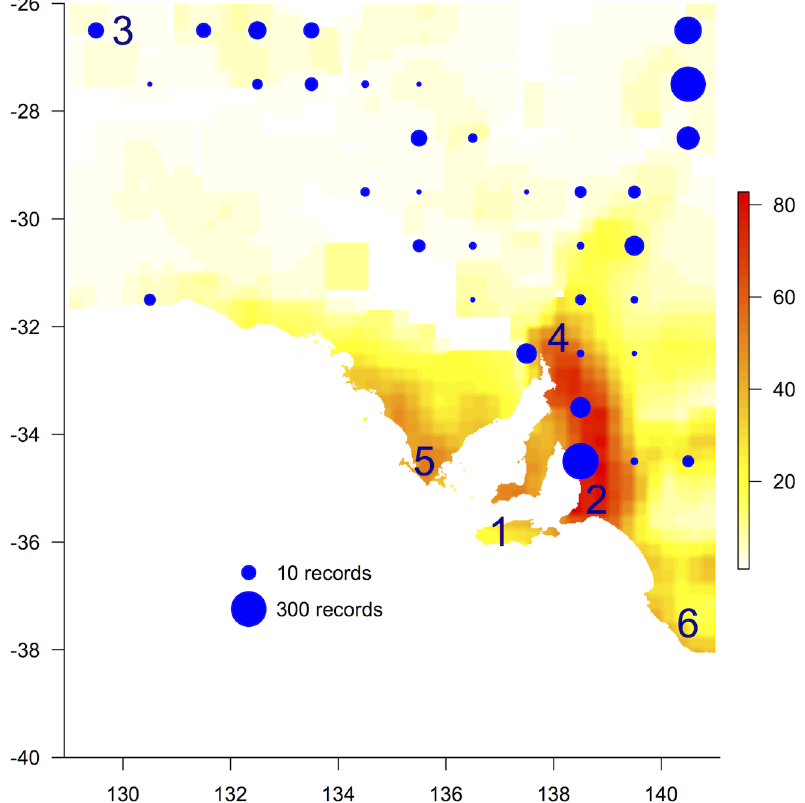
Fig 6. Species richness of introduced plant species (plot data). Circles represent the density of individual records of Buffel Grass ( Cenchrus ciliaris L.) within 1° grid cells on a logarithmic scale. Note, the number of records is influenced by sampling biases and does not directly indicate abundance. Numbers show locations of centres referred to in Table 2.